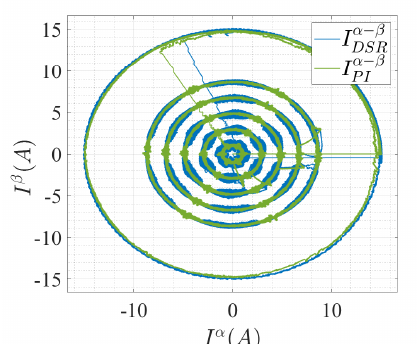
Figure 7. αβ stator current under variable load and speed reference.